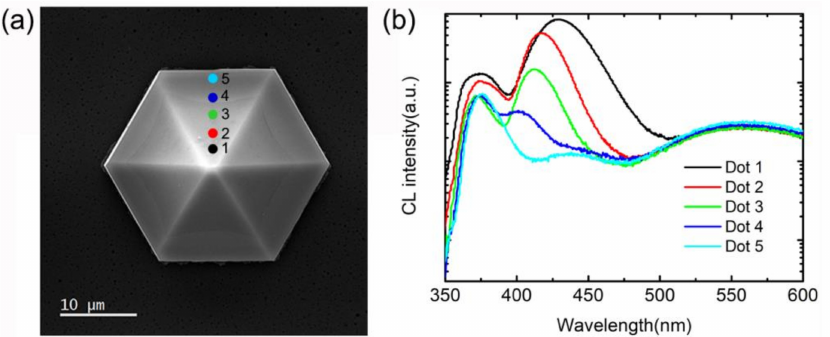
Figure 4. The top-view SEM image ( a ) and the position-dependent CL spectra of the semi-polar facet ( b ) of a single µ -LED pyramid. The five dot positions are labeled in Figure 4a. To evaluate the electrical performance of the µ -LED, n-type and p-type Ohmic contacts were deposited on the n-GaN region and the top of the pyramid arrays,